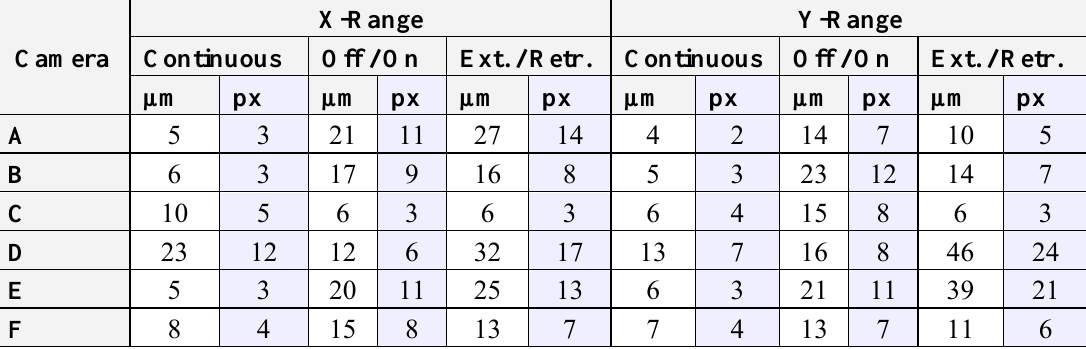
Table 4. Maximum variations in the position of the principal